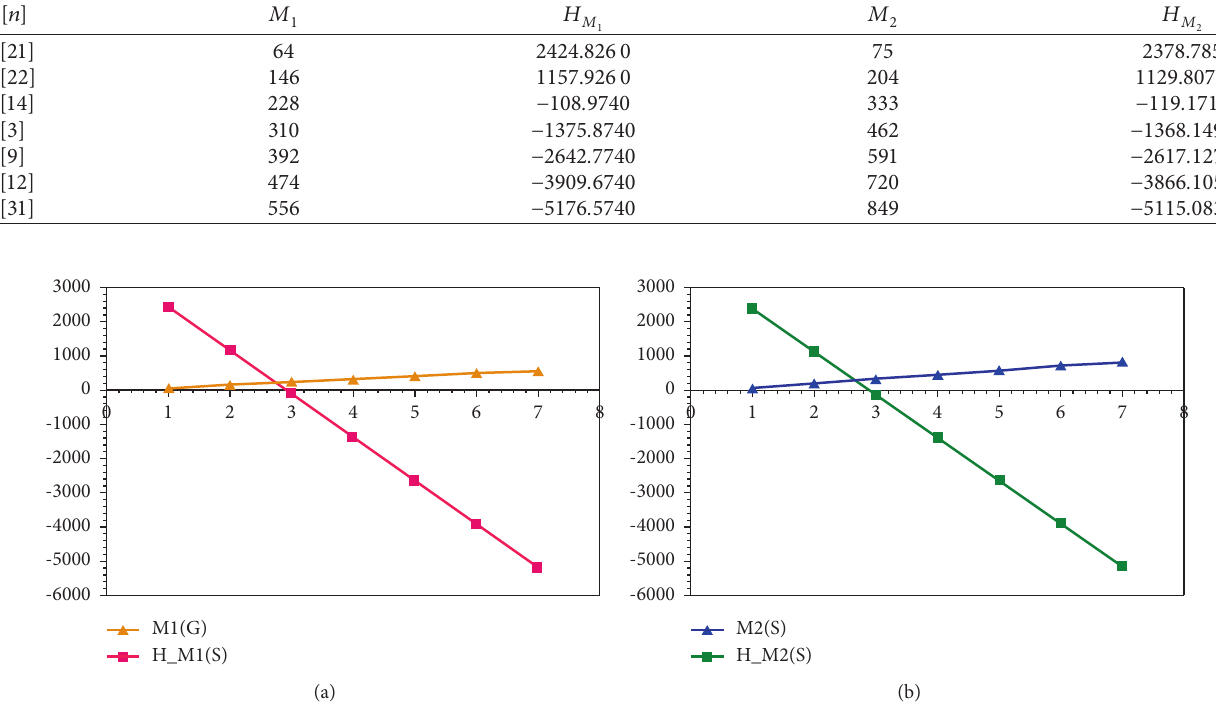
Figure 6: (a) The rirst Zagreb index with heat of formation. (b) The second Zagreb index with heat of